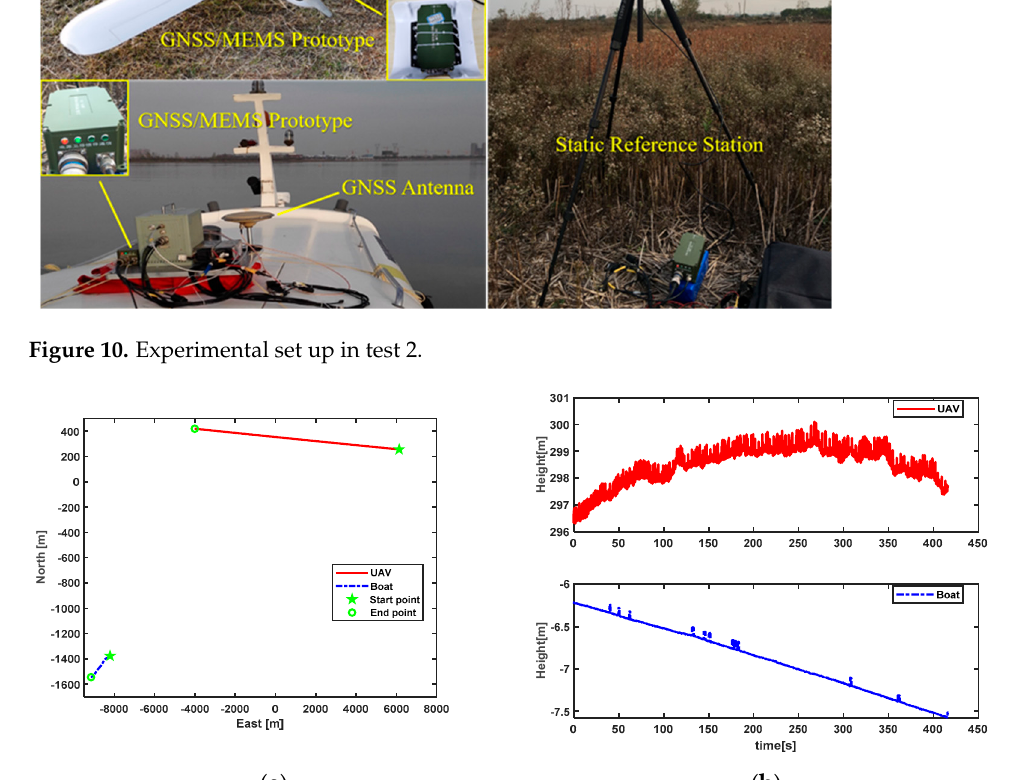
( b ) Figure 12. Velocities (NED) of the UAV and boat in test 2. ( a ) UAV; ( b ) boat. ( a ) ( b ) Figure 13. The number of visible satellites in field tests (15° elevation mask). ( a ) Test 1; ( b ) test 2. 3.1. Analysis of the Effect of Data Broadcast Rate and Sampling Rate If RTK DGNSS relative positioning is adopted to provide relative positions with a high output rate, the sampling rate of the GNSS receiver and broadcast rate between receivers should be increased by the same rate, which will increase the pressure of data